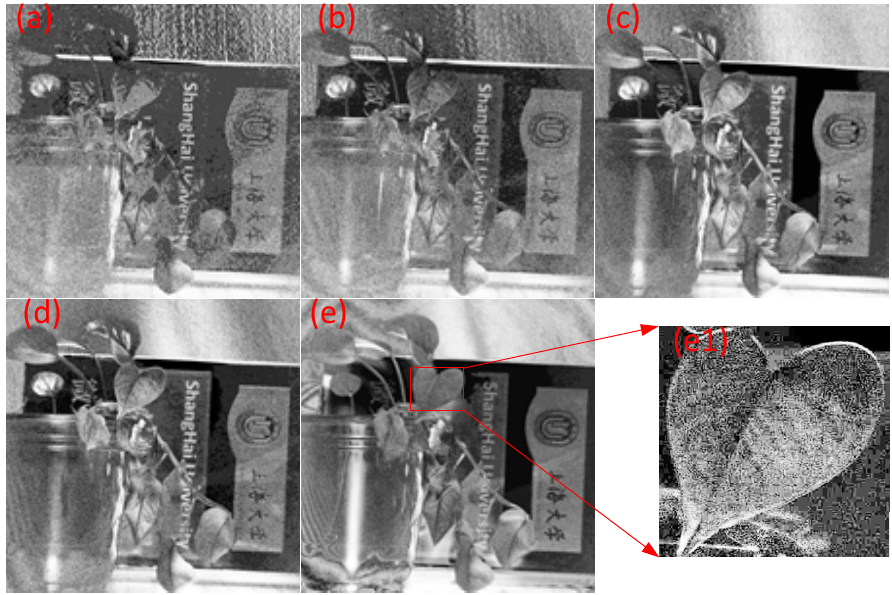
Figure 7. The DoLP with different illuminations. The illumination of the DoLP: ( a ) 0.01 lux, ( b ) 0.1 lux, ( c ) 0.5 lux, ( d ) 1.0 lux and ( e ) 5.0 lux. ( e1 ) The region of interest for the DoLP.